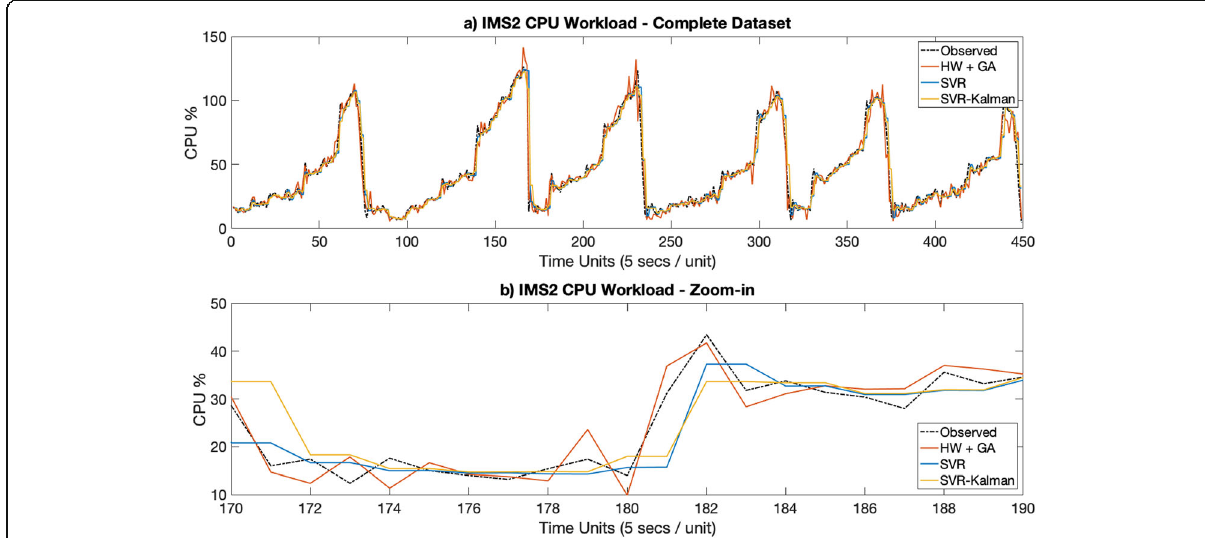
Fig. 4 IMS2 Observed and Estimated Data: a Complete dataset, b Zoom-in